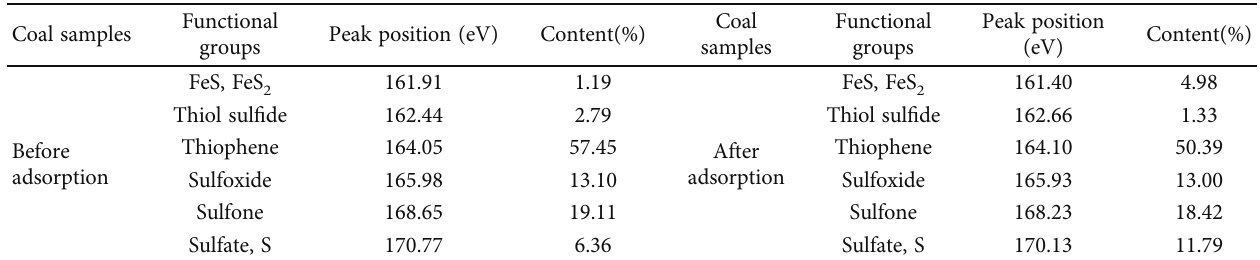
S adsorption by SP coal, (a) before adsorption and (b) after adsorption. 2 S adsorption in SP coal. 2